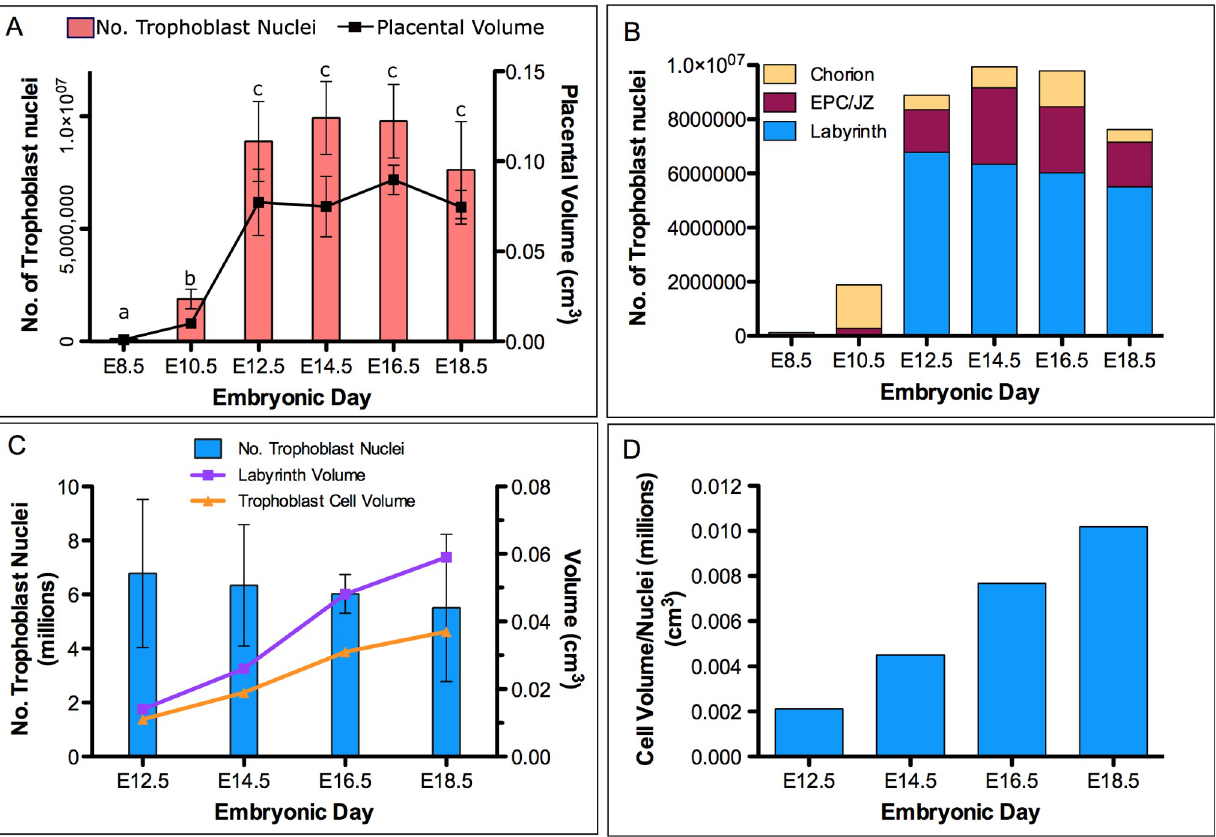
Fig 1. Number of trophoblast nuclei in each zone of the mouse placenta as determined using stereology. (A) Absolute number of trophoblast cell nuclei and total placenta volume. (B) Distribution of trophoblast cell nuclei among different layers of the placenta. (C) Number of trophoblast nuclei within the labyrinth layer (blue bars), as well as labyrinth volume (purple line) and trophoblast cell volume (orange line) from E12.5 to E18.5. (D) Trophoblast cell volume calculated as total trophoblast cell volume in the labyrinth (from C) divided by the number of trophoblast nuclei from E12.5 to E18.5. Different letter labels indicate significant differences between days (p < 0.05) and are valid for both volume and total trophoblast number (n =